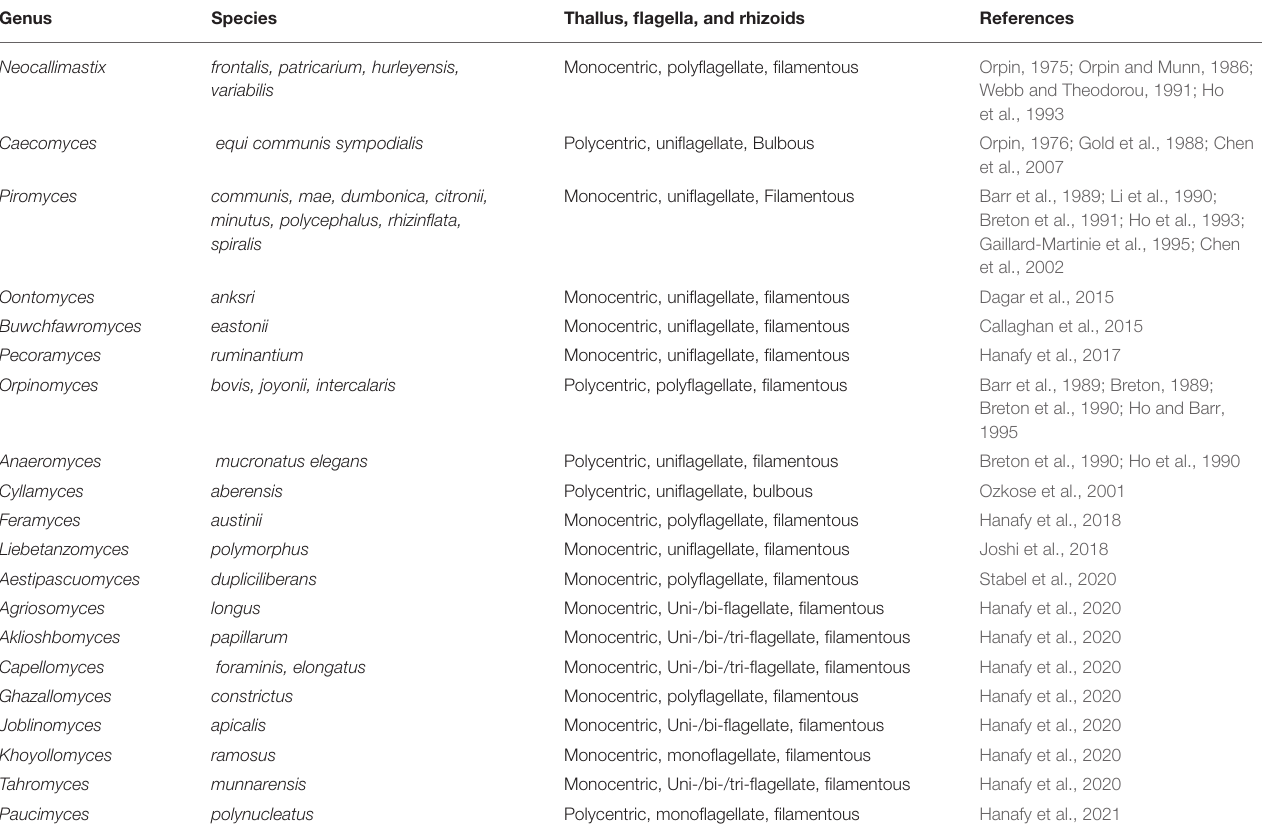
TABLE 4 | Genera and species of anaerobic gut fungi cultivated to